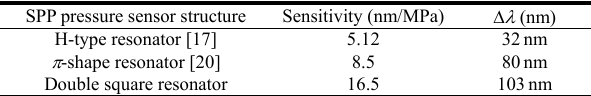
Table 1 Comparison between our structure and the previous ones in terms of sensitivity and resonance wavelength